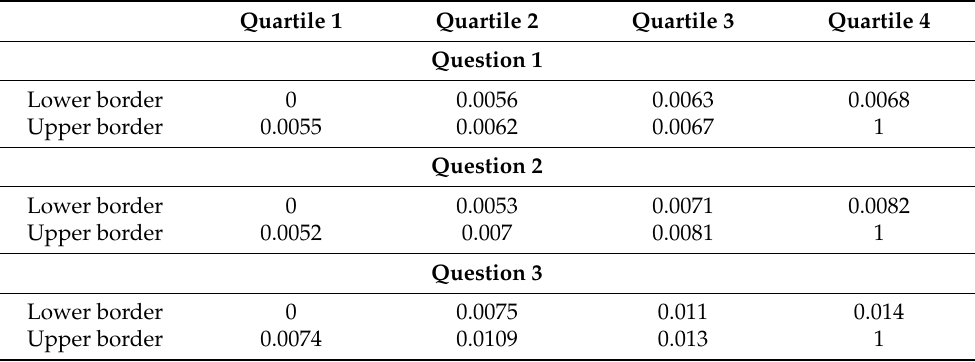
Table 1. The borders for the quartiles of reaction time